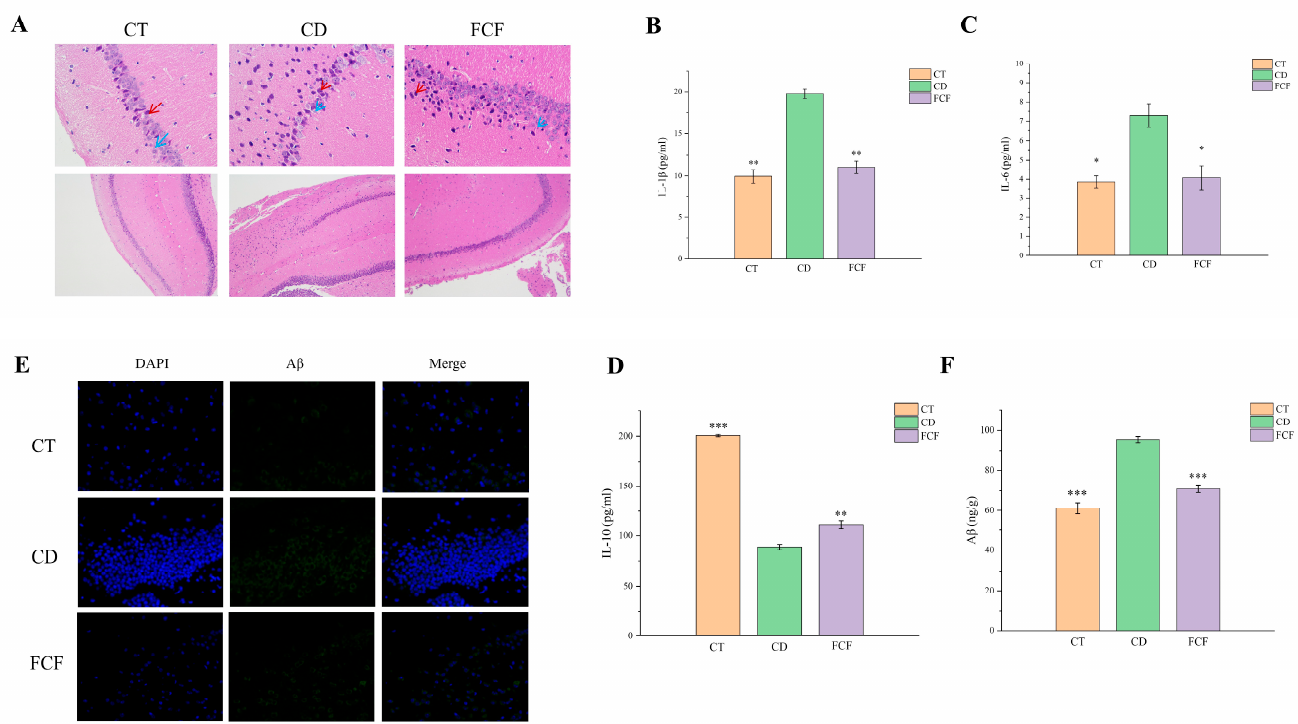
Figure 6. ( A ) Effects of FCF on hippocampal histomorphology in mice with circadian disturbance (HE, ×200 and ×400). Effects of FCF on the contents of proinflammatory factor IL-1 β ( B ), IL-6 ( C ) and anti-inflammatory IL-10 ( D ) in the hippocampus of mice with circadian rhythm disturbance. ( E ) Results of A β fluorescence staining in the hippocampus of each group (×400). ( F ) Effect of FCF on hippocampal A β level in mice with circadian disturbance. * p < 0.05, ** p < 0.01, *** p < 0.001, compared with the CD group.